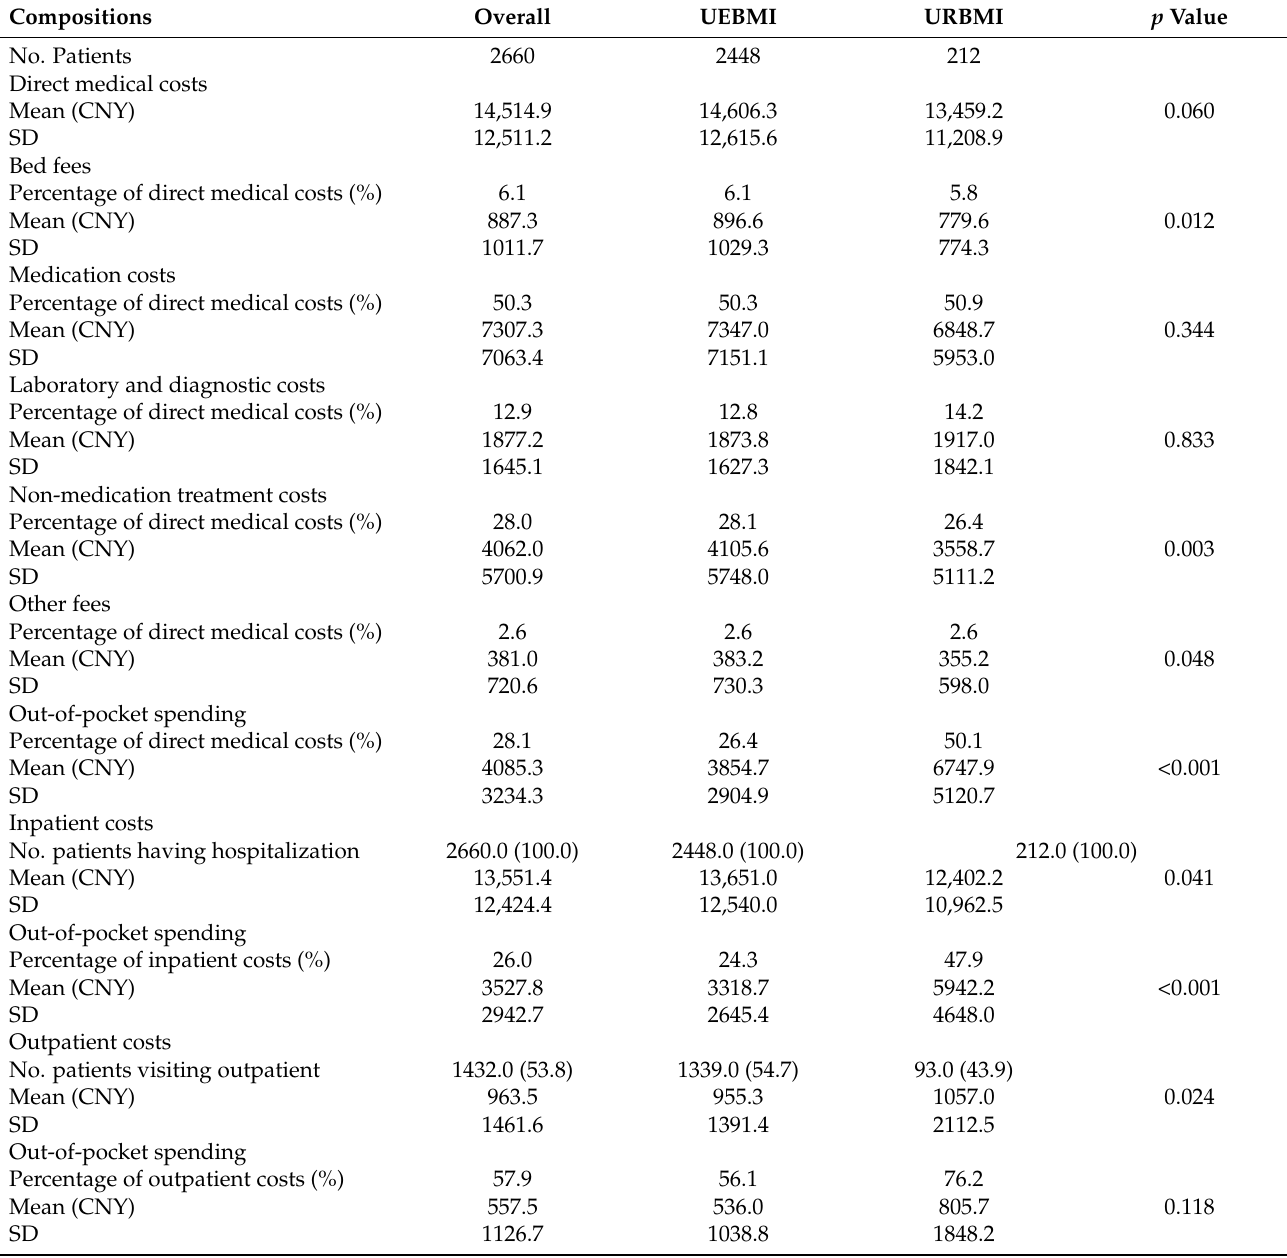
Table 5. Direct medical costs per patient by the type of